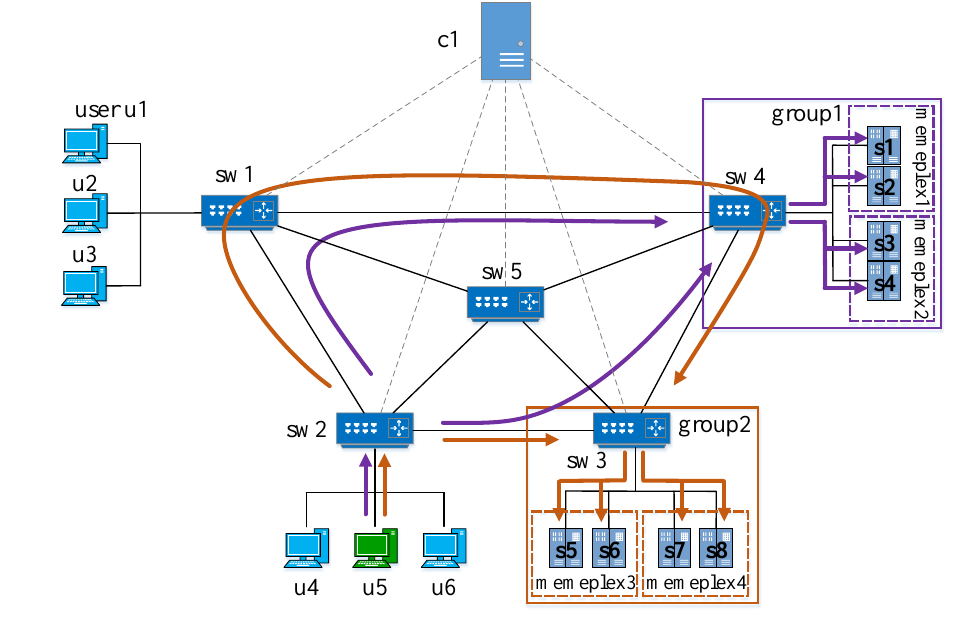
Figure 3. Design principle of the JSSTR algorithm. Table 2. Example of